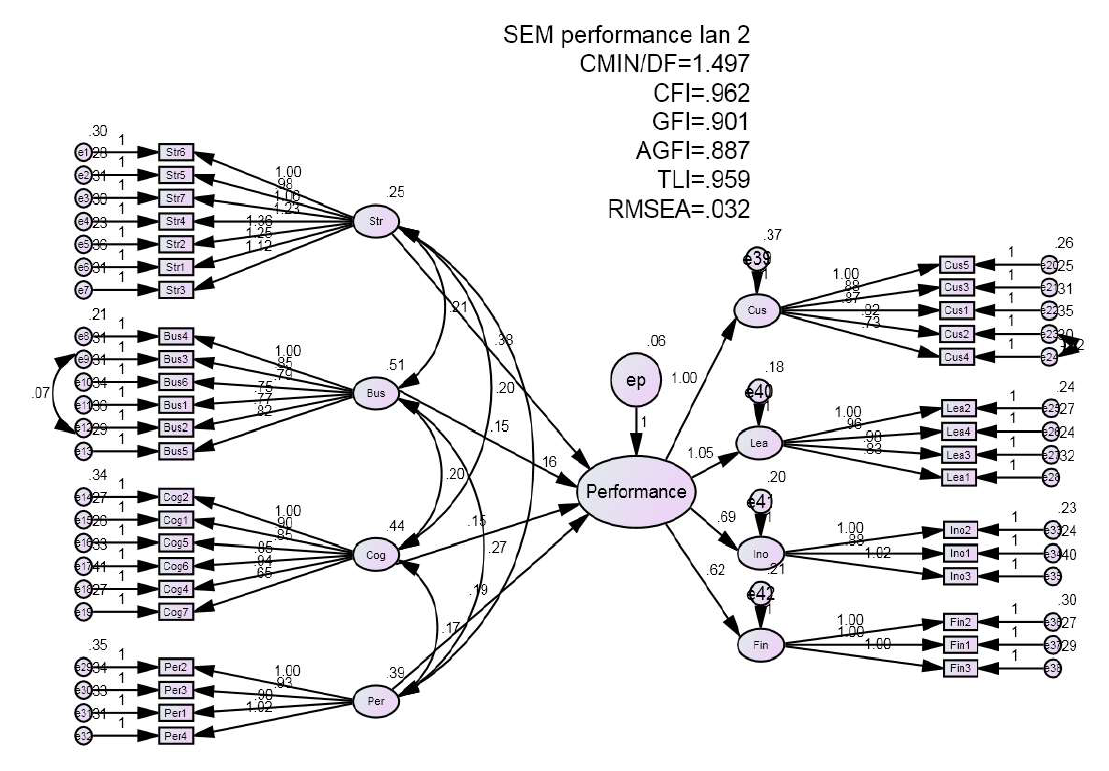
Fig. 3. SEM analysis